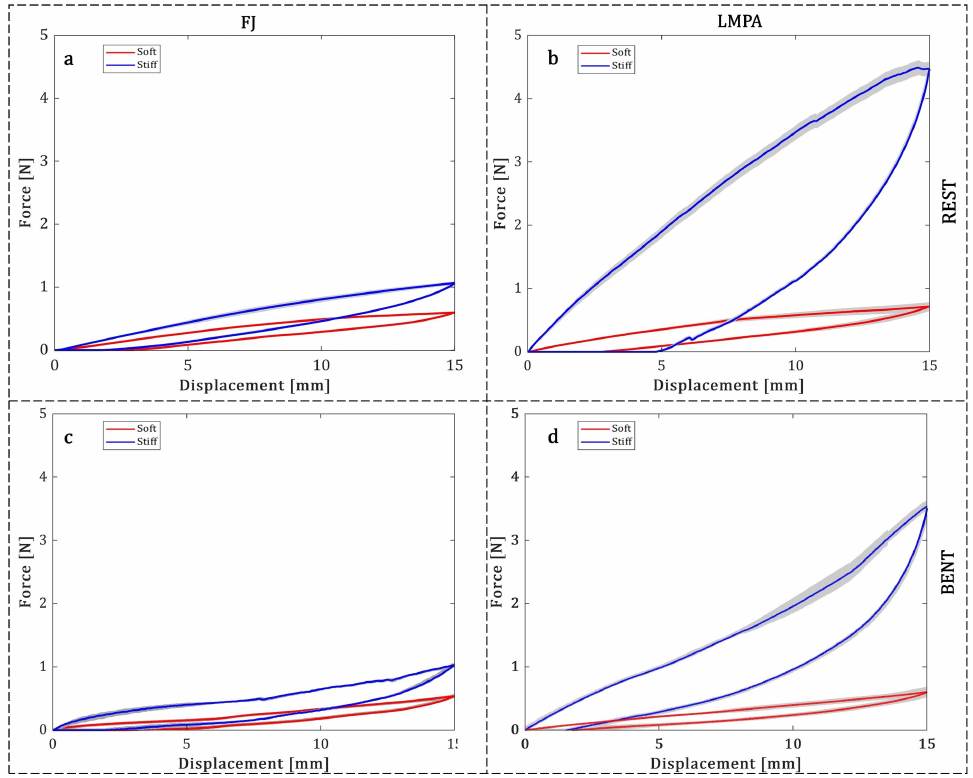
Figure 6. Force–displacement curves at rest position for ( a ) FJ and ( b ) LMPA module, and in the bent configuration for the ( c ) FJ and ( d ) LMPA module. Table 2. Results of the bending tests carried out at rest configuration to evaluate the maximum stiffness variation for the two